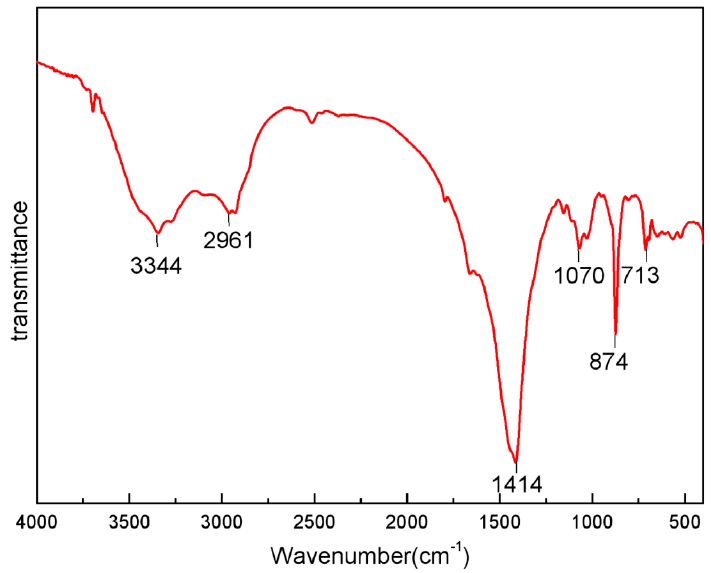
Figure 2. FT-IR spectrum for CSP.